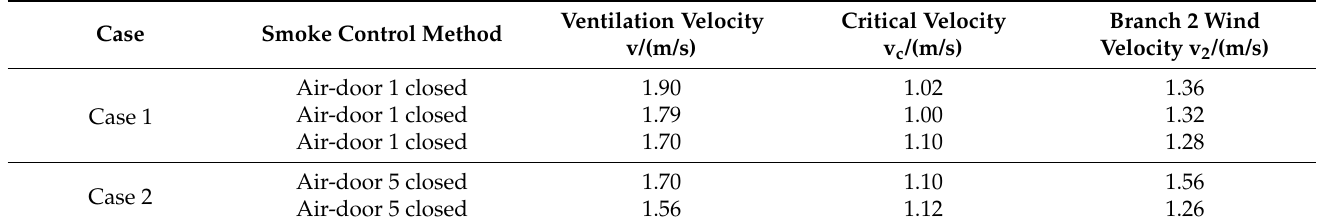
Table 4. Wind velocity in the ventilation network with a diagonal branch after the smoke control.